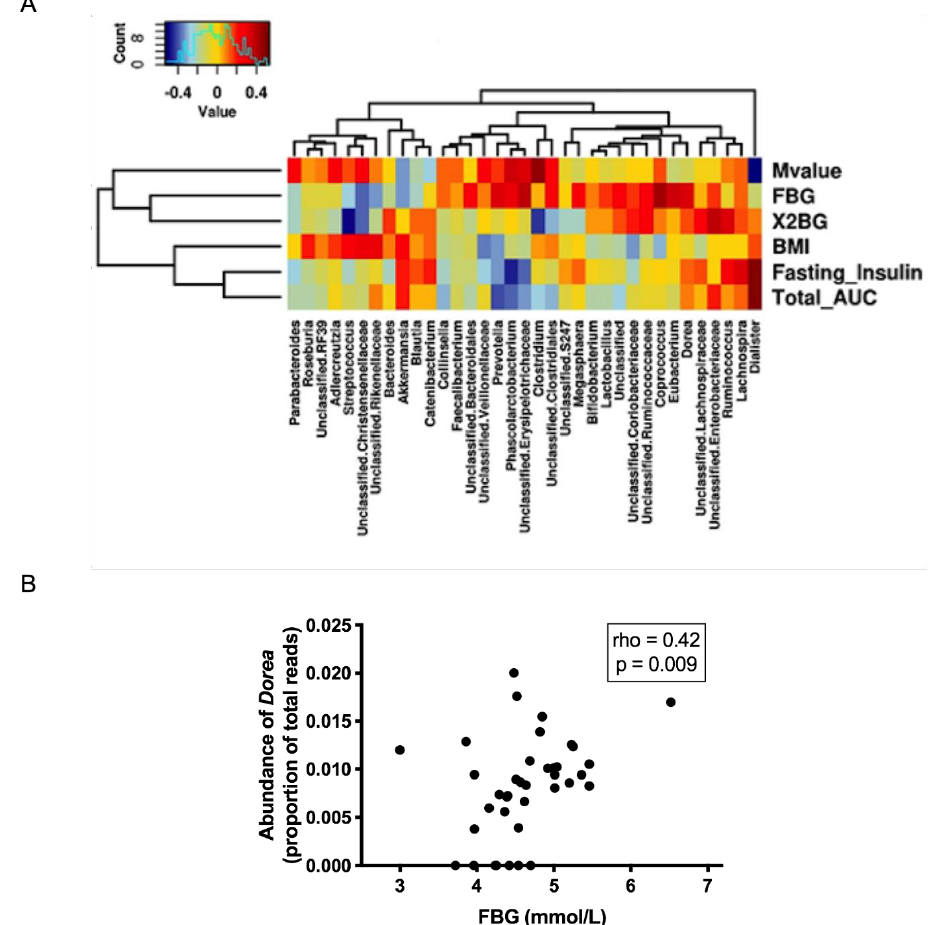
fasting blood glucose and genus Dorea . BMI: body mass index, FBG: fasting blood glucose level, x2BG: 2-hour blood glucose level post-oral glucose tolerance test, Total AUC: total insulin area under the